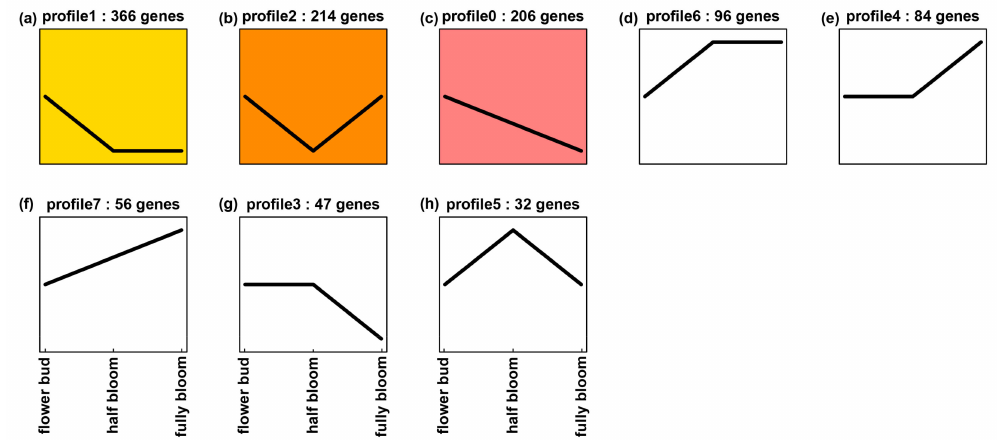
Figure 9. Eight expression trend profiles established from coupled expression analysis of ANR and 1110 transcription factor genes annotated from three transcriptomes sequenced for three developmental stage flower samples, flower buds, half blooming (half bloom), and fully blooming (fully bloom). ( a – h ) eight expression trend profiles. This result reveals that the expression trend of ANR is the same as those of 205 TF genes characterized in profile 0 ( c